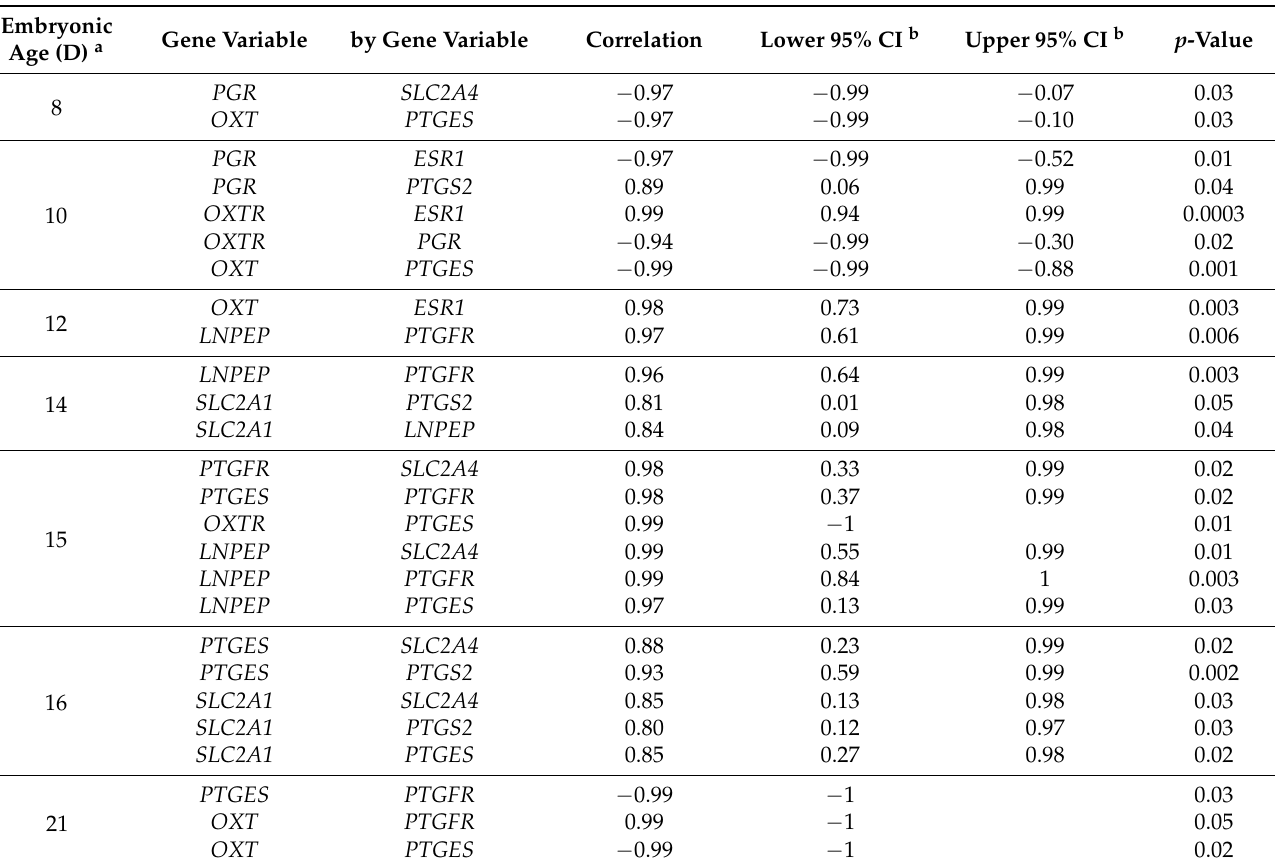
Table 3. Correlation between equine embryonic age in days post-ovulation and gene expression of selected embryonic